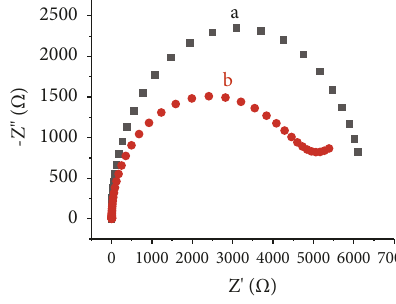
Figure 7: EIS plots of the unmodified CPE (a) and HDPBA modified CPE (b) in 0.1 M Britton Robinson (B-R) solution having 100 µ M Cd(II). Potential: 0V; frequency: 0.1–100000Hz; ampli- tude: 0.005V.